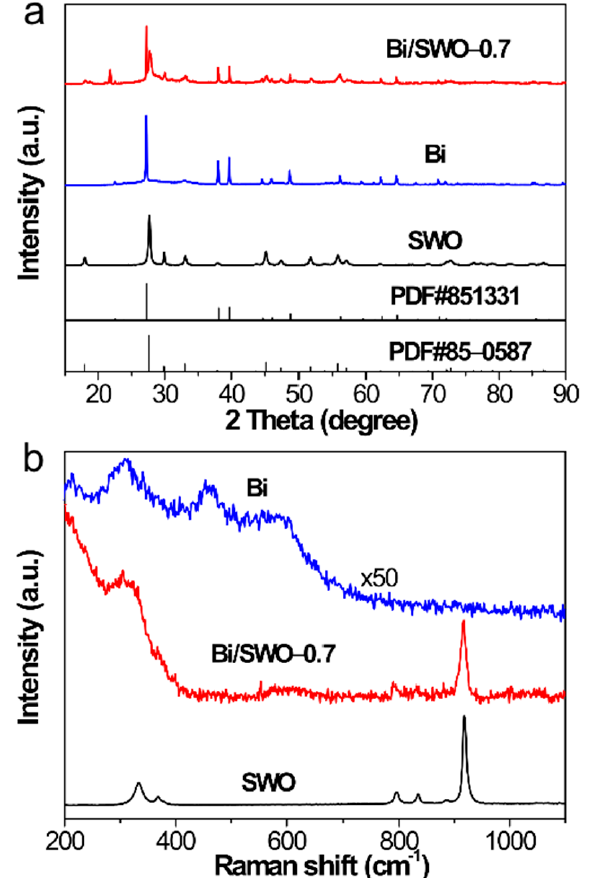
Figure 1 . XRD patterns ( a ) and Raman spectra ( b ) of prepared Bi, SWO and Bi/SWO-0.7. To elucidate the detailed oxidation states of Bi in Bi/SWO-0.7, X-ray photoelectron spectroscopy (XPS) was conducted (Figure 2). It was found that two main peaks centered around 157.08 eV and 162.35 eV are typically attributed to the Bi-Bi bonds of metallic Bi (Figure 2a), while the narrow Gauss-shaped symmetrical Bi 4f 7/2 (158.96 eV) and Bi 4f 5/2 (164.27 eV) core spectra are characteristic of the Bi 3+ oxidation state in Bi 2 O 3 [40,41]. According to the deconvoluted peaks of reference Bi, the discrete area ratio of metallic Bi to Bi 3+ reflected the importance of the existence of host support during glucose-induced in-situ reduction in hydrothermal process [42]. Prior to Bi loading, the curve fitting in the O 1s region (Figure 2b) was attributed to lattice oxygen (530.37 eV) in SrWO 4 and adsorbed oxygen of OH – or CO 32– (531.02 eV) on the surface. Additionally, the binding energies of Bi-O in Bi/SWO-0.7 and reference Bi are accordingly found to be 529.60 eV and 529.52 eV. However, the dramatic increment of oxide intensities was identified on reference Bi, suggesting that the richer metallic Bi predominantly formed on the surface of Bi/SWO-0.7 instead. The Sr 3d 5/2 and Sr 3d 3/2 orbitals of SWO are located at 133.15 eV and 134.91 eV (Figure 2c), while the W 4f 7/2 and W 4f 5/2 are located at 35.42 eV and 37.58 eV (Figure 2d), respectively. It can be seen that both spin orbitals of Sr 3d (132.77 eV and 134.53 eV) and W 4f (34.87 eV and 37.02 eV) for Bi/SWO-0.7 are both negatively shifted to the lower binding energies, attributed to the stereochemical activity of s orbitals through the feasible interfacial electron transfer between the 6s 2 lone-pair electrons of Bi and the [WO 4 ] 2 − tetrahedron [43]. All these results confirmed that the Bi/SWO-0.7 heterostructure was successfully prepared, as well as the strong interaction between the metallic Bi and SrWO 4